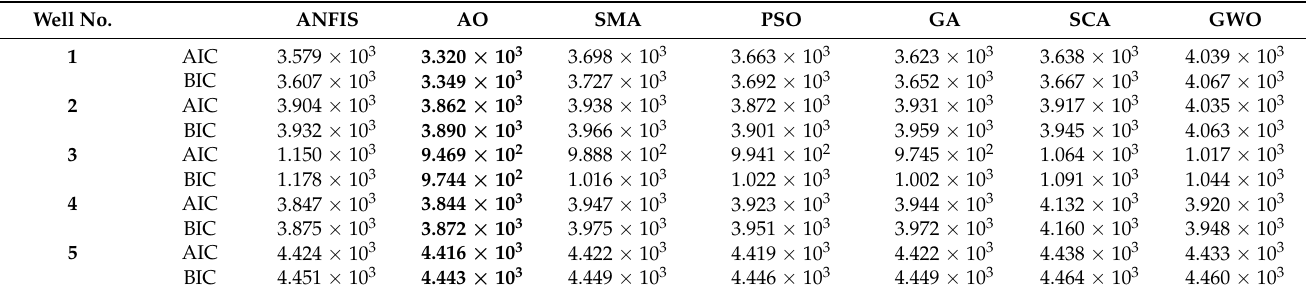
Table 6. The results of the Tahe oilfield, China, in terms of AIC and BIC measures. The best values are shown in bold. Well